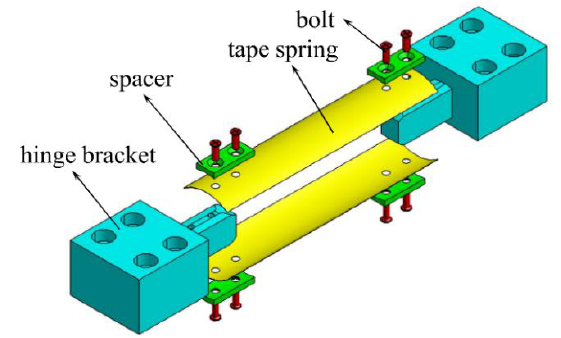
Figure 3. Tape spring hinge configuration [22].